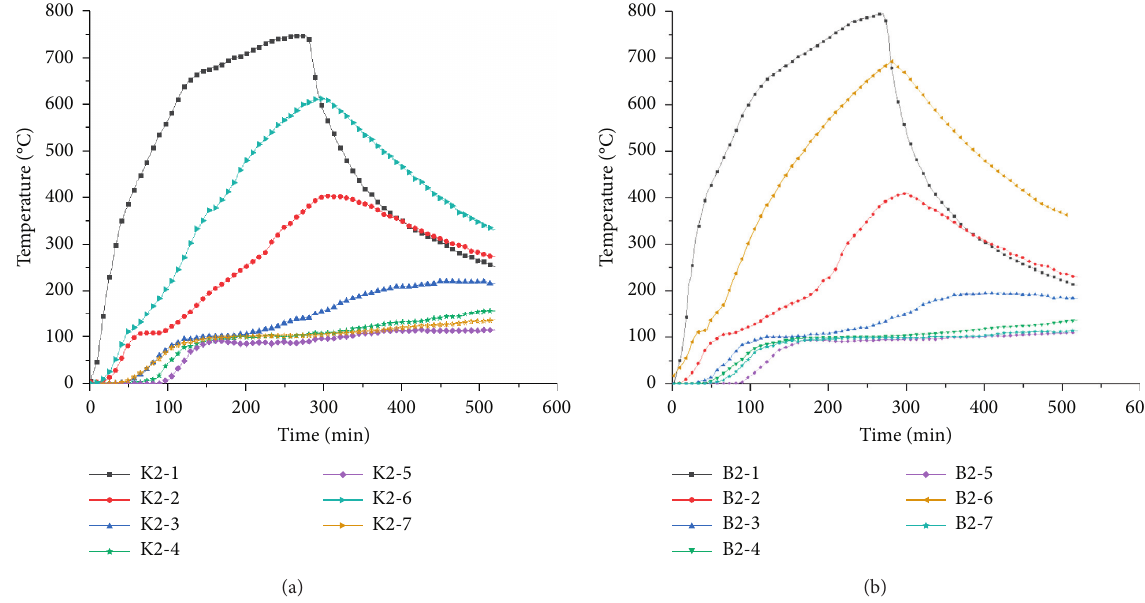
Figure 14: Temperature-time relationship of frame hidden girders and edge girders. (a) K2 measure point; (b) B2 measure point.